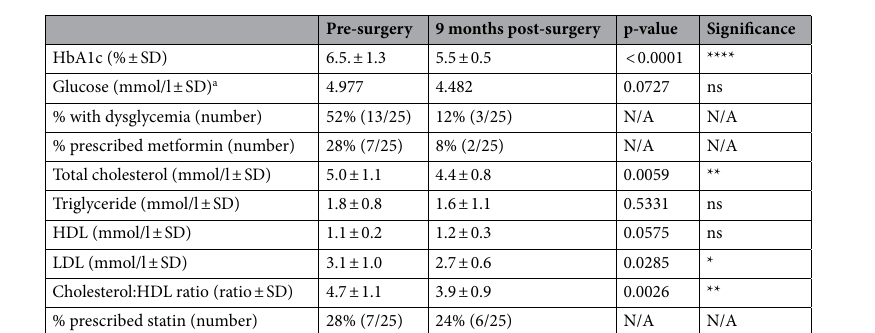
Figure 1. Mean plasma HbA1c, total cholesterol, triglyceride, HDL and LDL concentrations in participants before (Pre-Op) and 9 months after (Post-Op) bariatric surgery. Error bars show the means values ± standard deviation. The p-values were calculated using paired T-test. Statistical significance is indicated as: ns not significant (p > 0.05), *p ≤ 0.05 and **p ≤ 0.01, ***p ≤ 0.001 and ****p ≤ 0.0001.